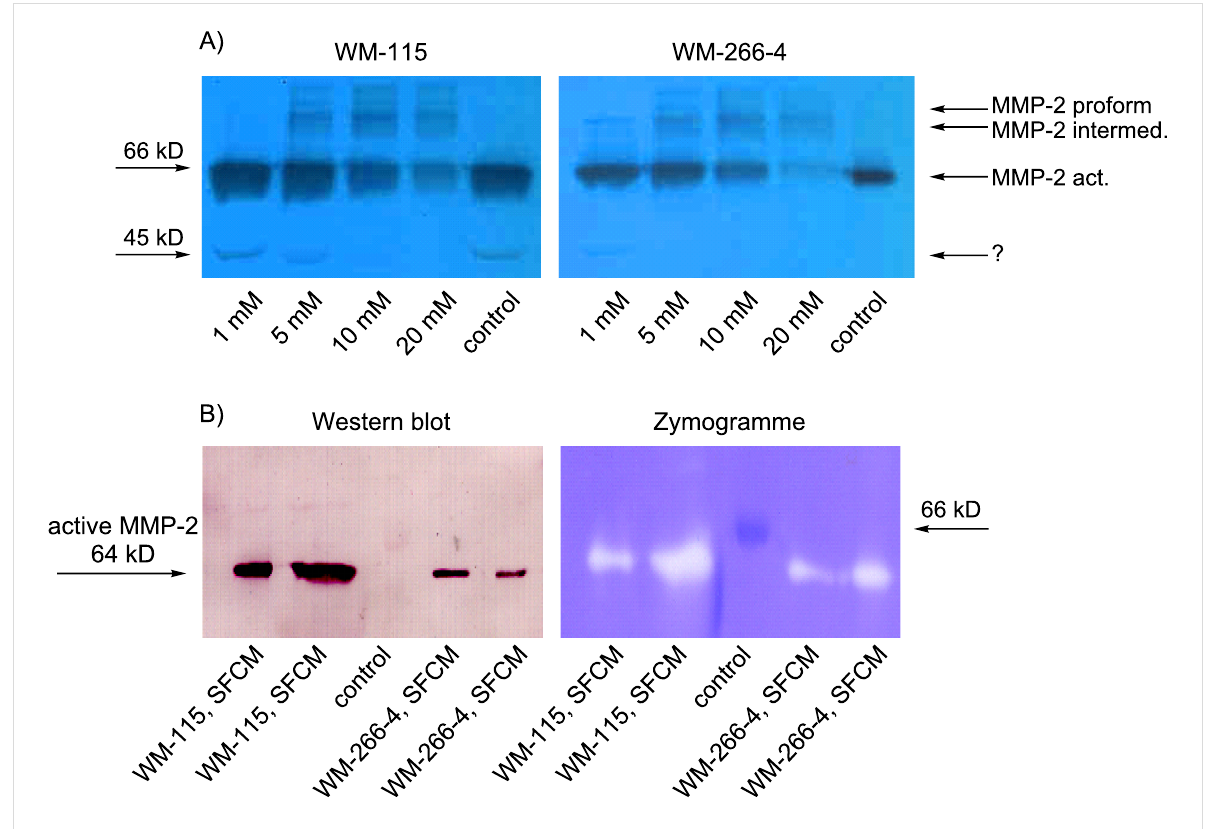
Figure 6: A: Zymograms (color inverted) of serum-free conditioned medium of melanoma cells treated with (4-{[( β -D- galactopyranosyl)oxy]methyl}furan-3-yl)methyl hydrogen sulfate (GSF) for 24 h at the concentrations indicated. Dark bands are the result of gelati- nolytic activity of the proteins migrating into the gel. Molecular weights in kilodalton (kD) are indicated on the left. B: Western blot on the left analyzed with anti-MMP-2 antibodies showing that the gelatinolytic activity determined in parallel in the gel on the right is caused by activated MMP-2. “Control” lane is a molecular weight standard